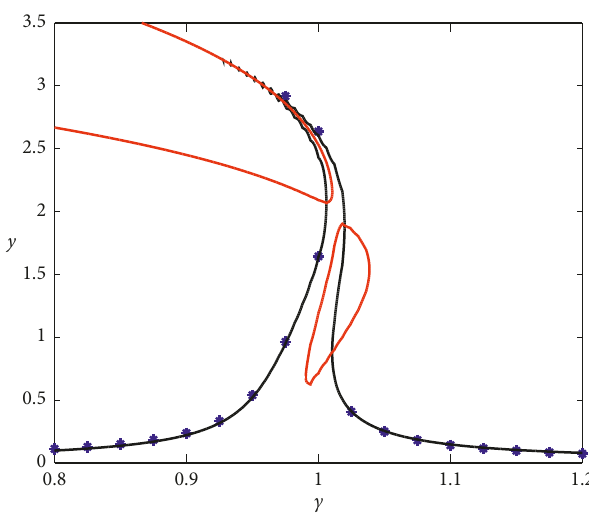
Figure 3: Response amplitude